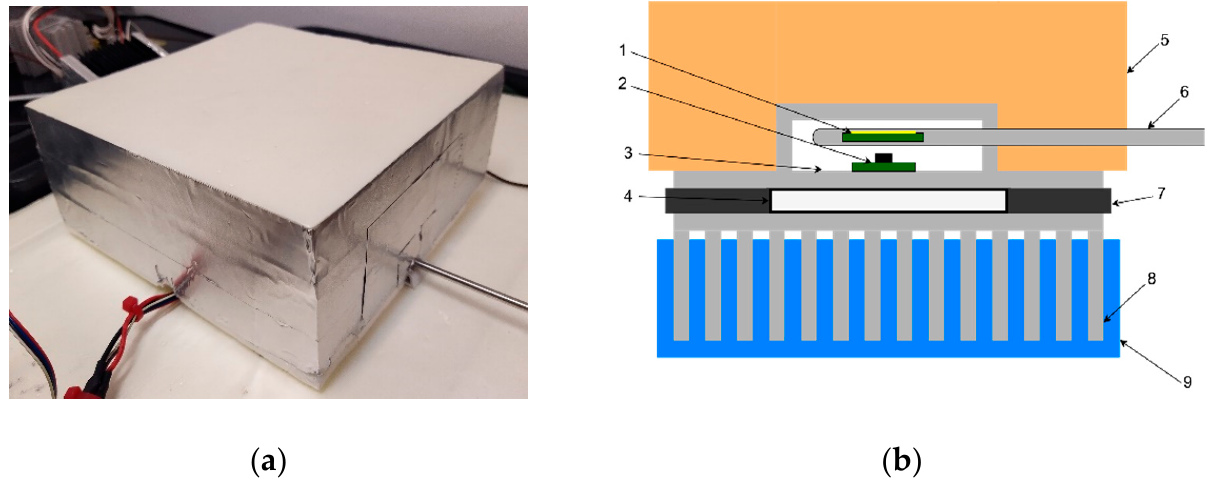
Figure 2. Proposed test chamber ( a ) assembled unit; ( b ) schematic diagram (1 − QCM assembly, 2 − temperature sensor, 3 − aluminum plate, 4 − TEC, 5 − extruded polystyrene insulation, 6 − Testo Pt100 probe, 7 − thermal insulation, 8 − heatsink, 9 − water bath).As presented in Figure 2b, TEC (4) was placed between an aluminum plate (3) and heatsink (8). The plate serves as the thermally